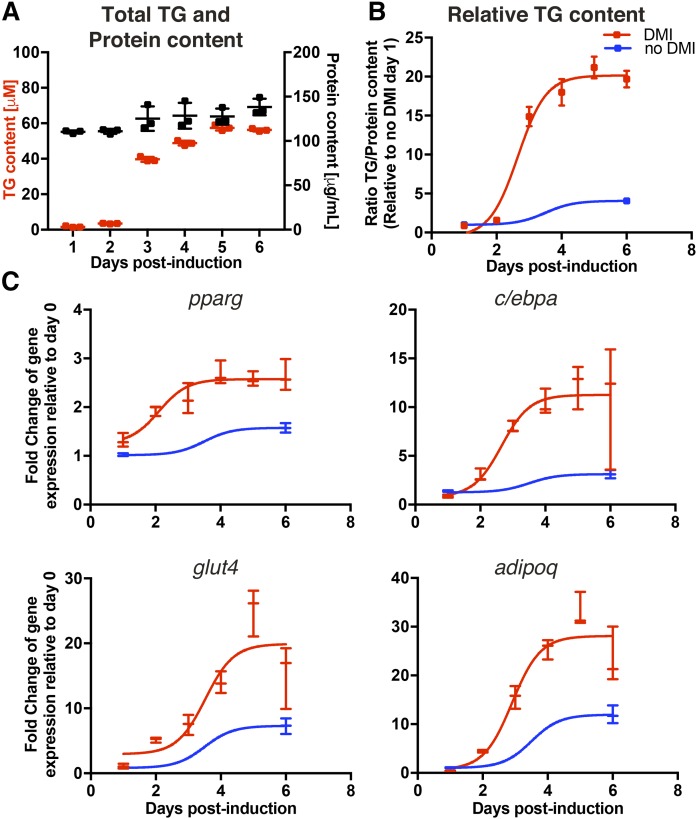
A: Total TG and protein content of OP9 cells during the 6 day adipocytic differentiation. Quantification is based on the standard curve from the manufacturer’s control. B: Relative TG content over protein content during the 6 day differentiation. C: The transcriptional profile of relevant genes involved in the adipocytic differentiation of OP9 cells. Values are normalized to noninduced OP9 cells 1 day postplating and the geometric mean of two housekeeping genes: hprt1 and actb. Error bars are SD.